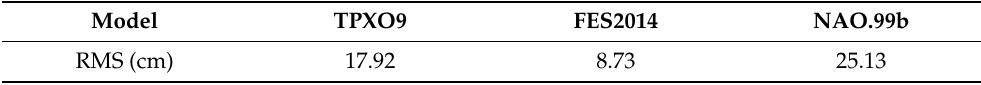
Table 5. RMS errors between tide gauge data and model